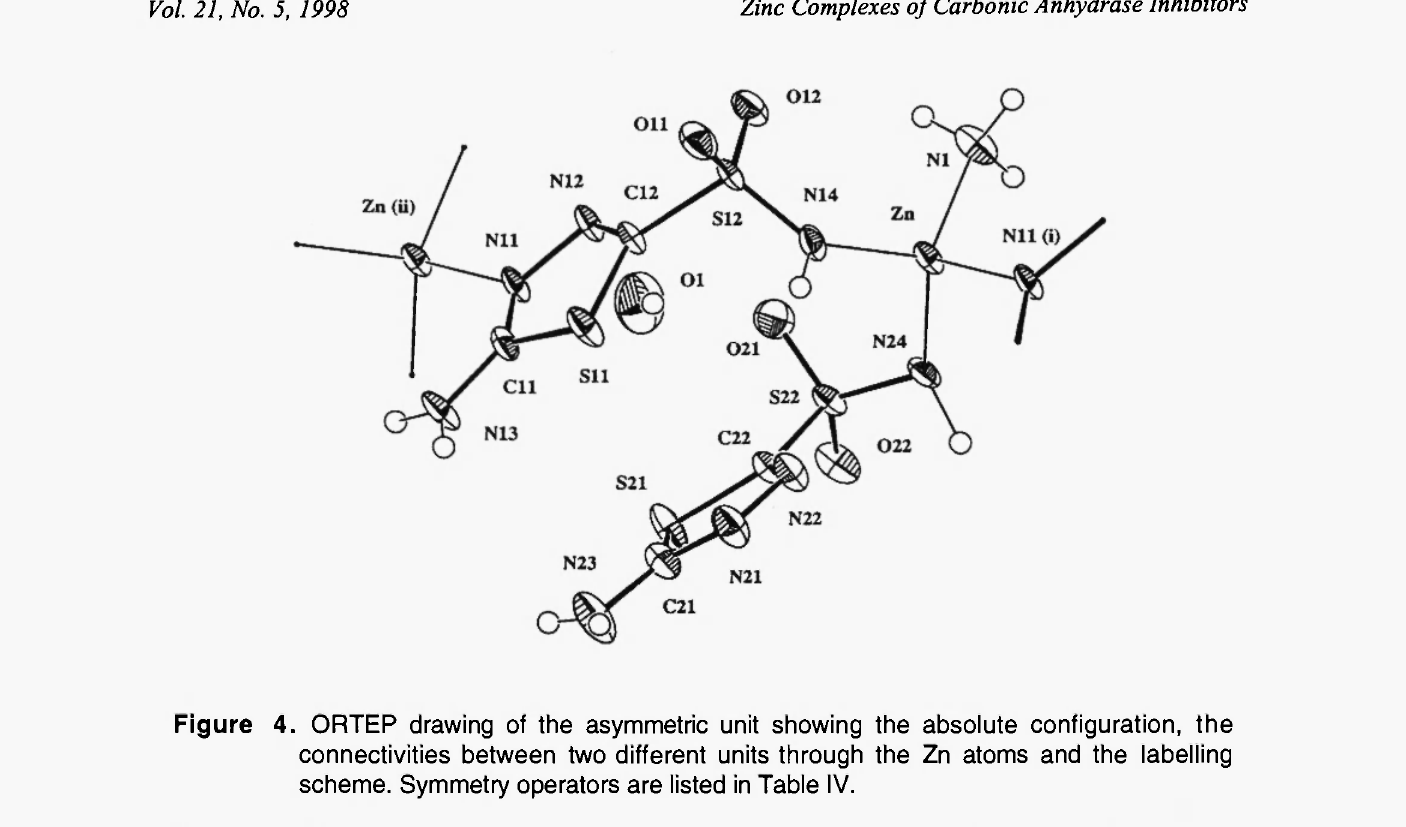
Figure 4. ORTEP drawing of the asymmetric unit showing the absolute configuration, the connectivities between two different units through the Zn atoms and the labelling scheme. Symmetry operators are listed in Table IV.